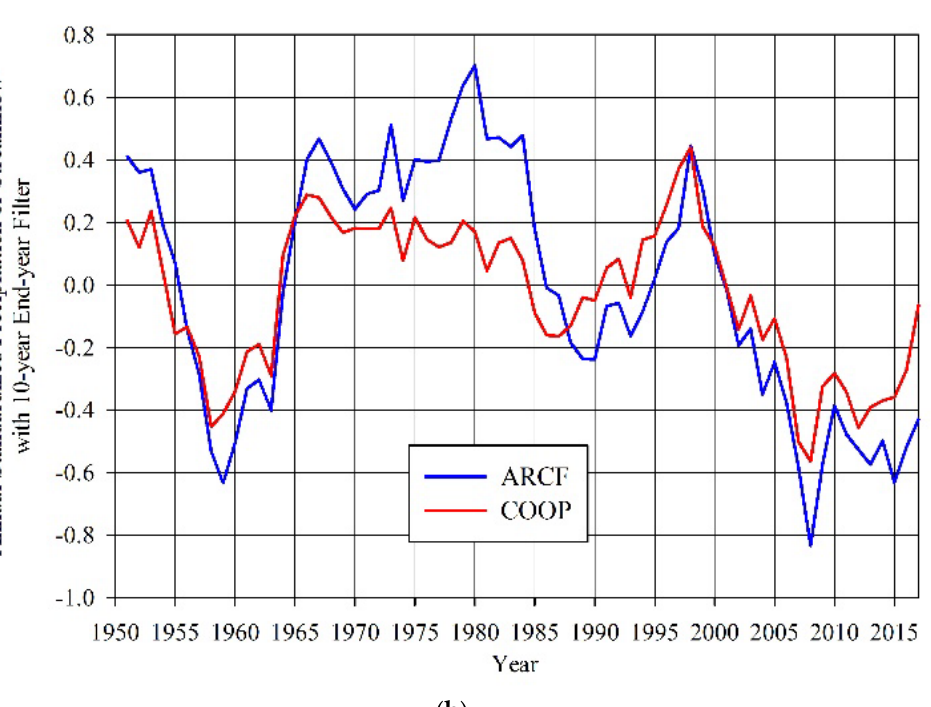
Figure 3. Annual standardized precipitation or streamflow with 10-year end-year filter from 1951– 2017 (based on annual data of 1942–2017) ( a ) NOAA COOP precipitation stations (Newnan GA, West Point GA, Bainbridge GA, Talbotton GA, Camilla GA, Albany GA, Atlanta GA, and COOP Average ( b ) COOP Average and ARCF streamflow.